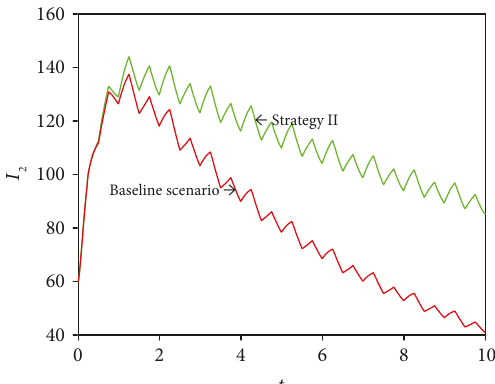
Figure 5: Time series plot of the total infected trees for the baseline scenario and Strategy II.